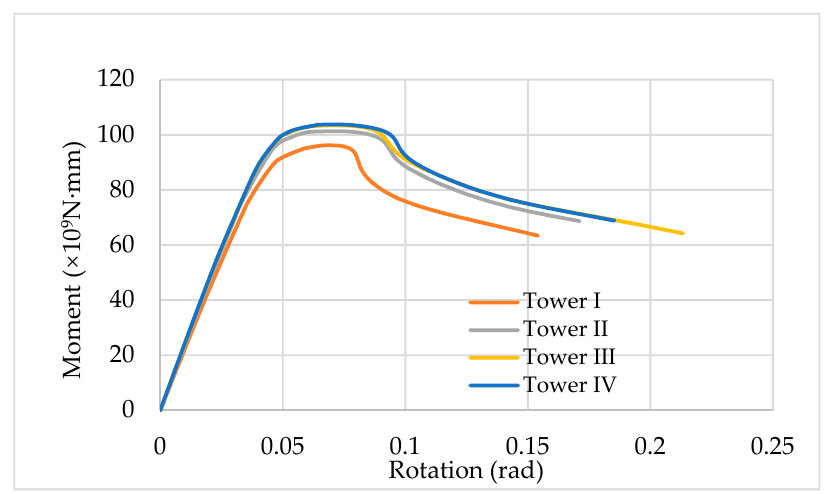
Figure 22. Moment versus rotation of Towers I, II, III, IV.